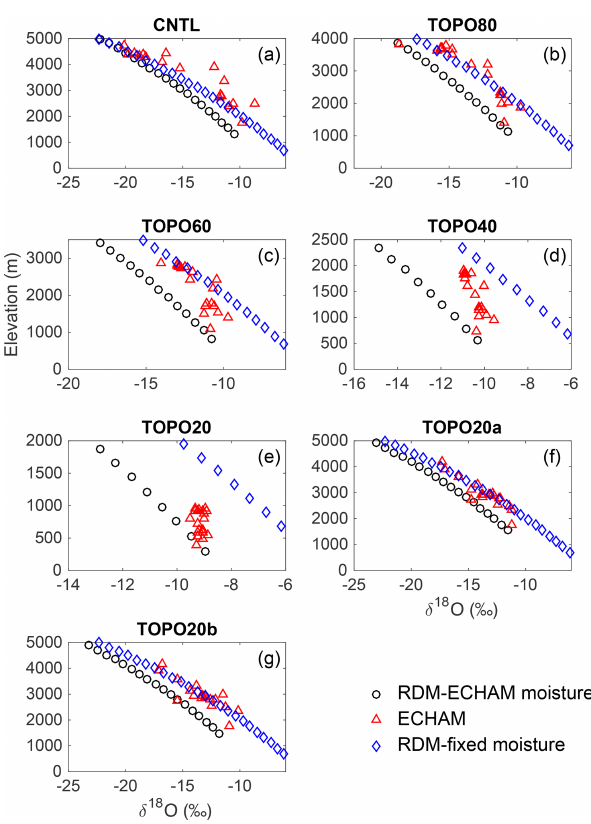
Figure 8. δ 18 O p (‰) versus elevation (m) for the Indian sum- mer monsoon (ISM) region of the southern Himalayan flank as simulated by ECHAM5 (blue triangle, annual-mean precipitation- weighted), RDM initiated with ECHAM5 summertime moisture sources (black circle), and RDM initiated with fixed moisture sources of T = 20 ◦ C and RH = 80% (red diamond) for the (a) CNTL, (b) TOPO80, (c) TOPO60, (d) TOPO40, (e) TOPO20, (f) TOPO20a, and (g) TOPO20b